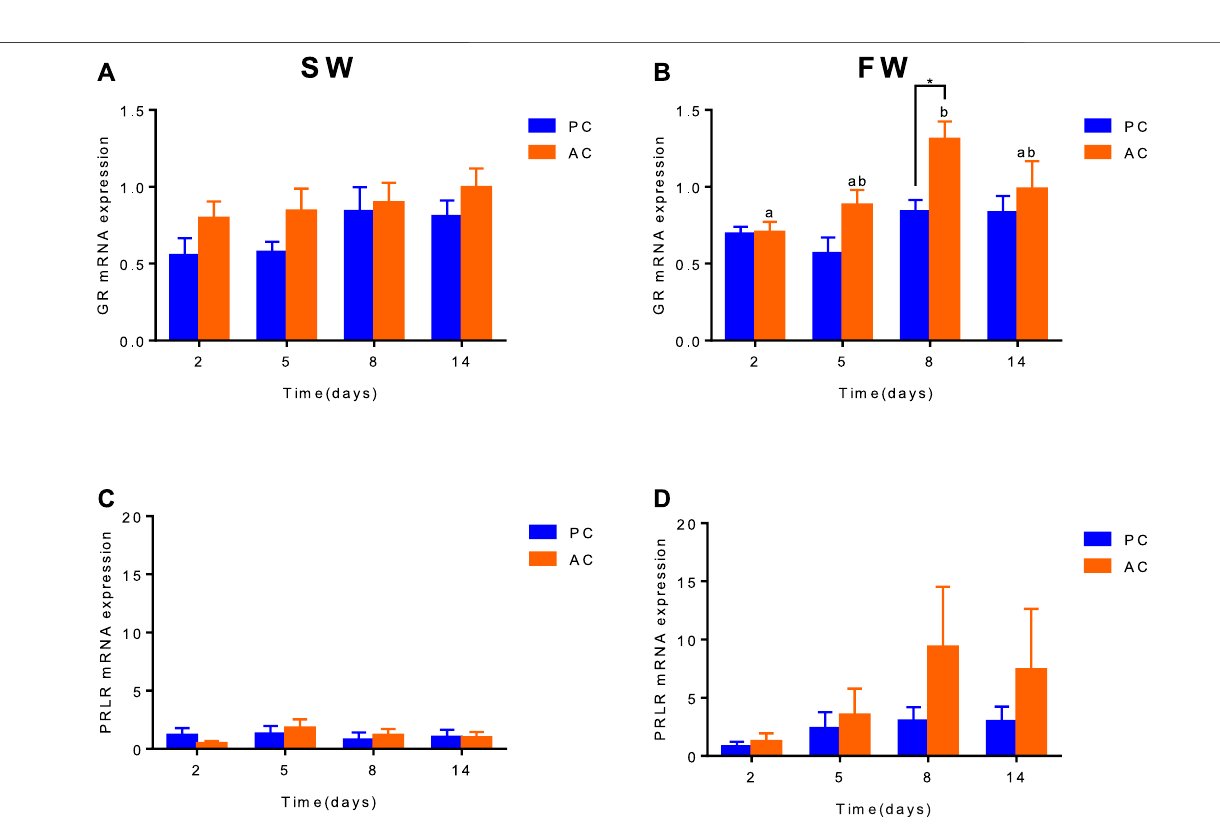
Frontiers in Physiology |